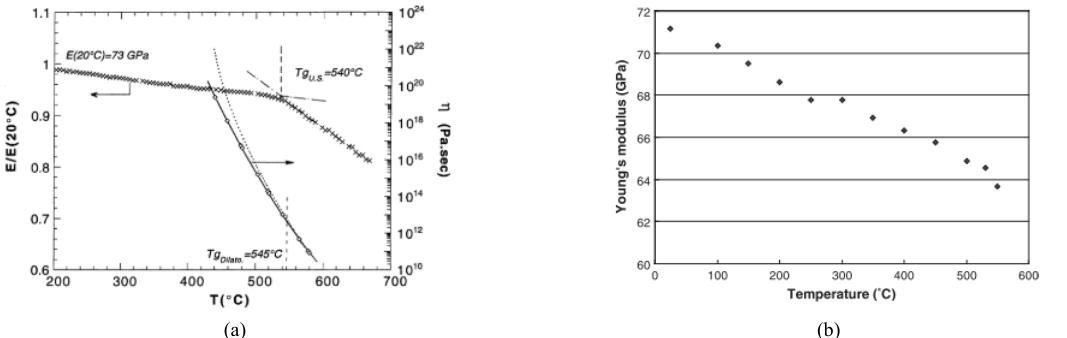
Fig. 1 AN SLS glass: Temperature dependence of (a) Young’s modulus and viscosity coefficient (Rouxel et al. 2000) and (b) Young’s modulus (Shen et al.